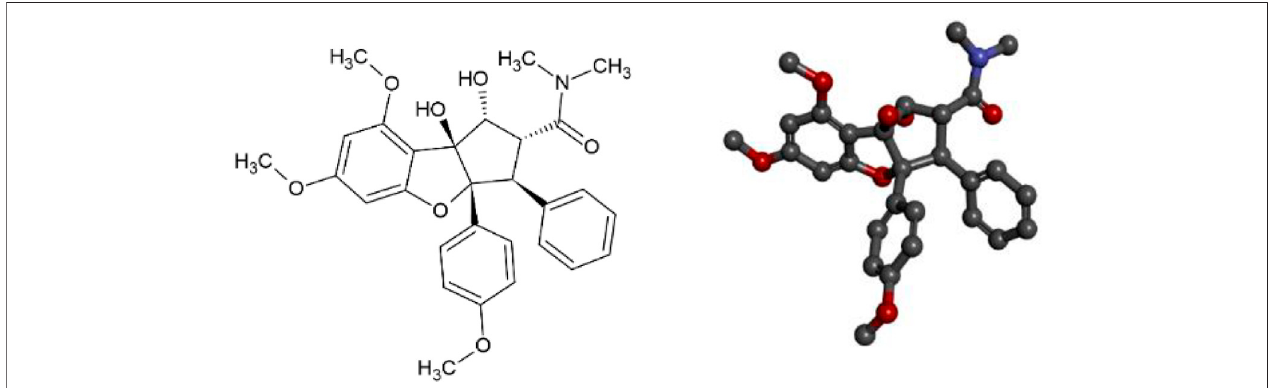
FIGURE 1 | Representation of 2D and 3D structures of Roc-A (1R,2R,3S,3aR,8bS)-1,8b-dihydroxy-6,8-dimethoxy-3a-(4-methoxyphenyl)-N,N-dimethyl-3-phenyl-2,3- dihydro-1H-cyclopenta